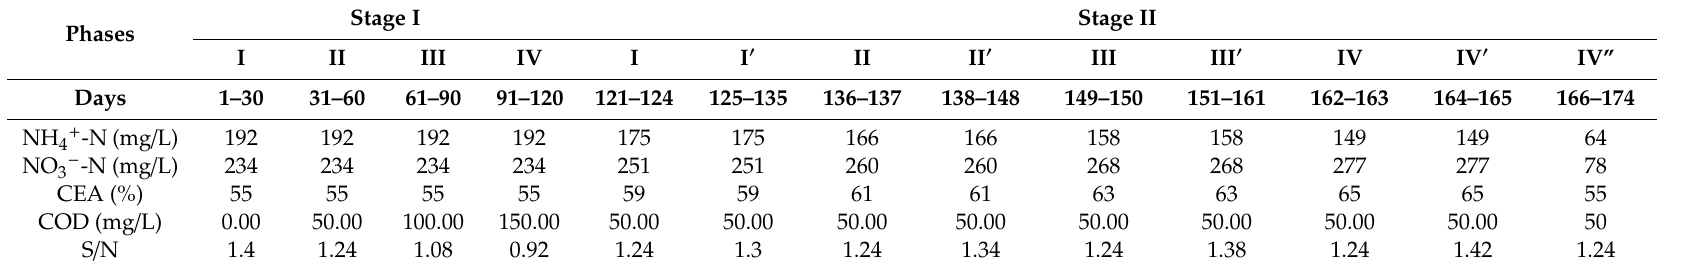
Table 1. Operating conditions of the expanded granular sludge bed (EGSB) reactor in stage I and stage